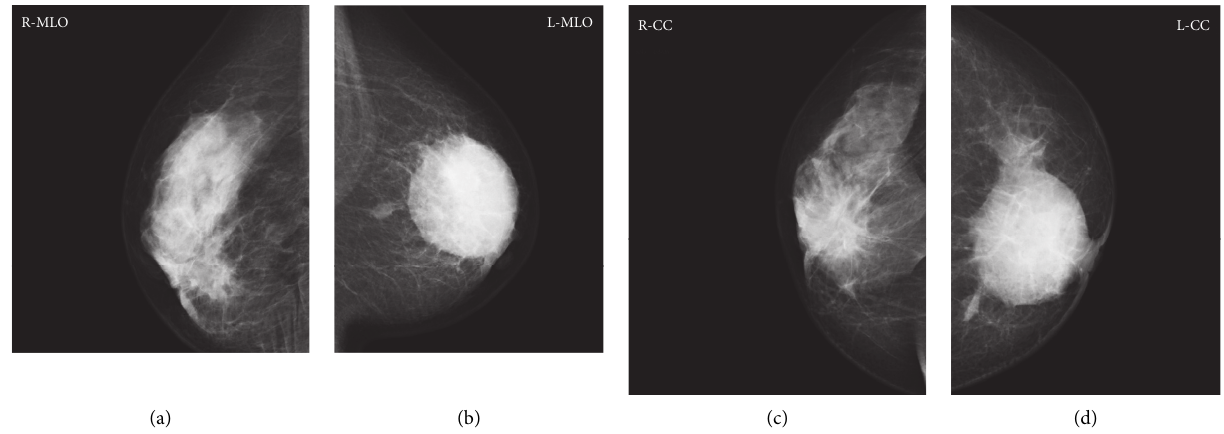
Figure 3: Mediolateral oblique (a, b) and craniocaudal (c, d) mammography demonstrates a round, microlobulated, and high-density mass lesion in the right breast (a, c) and circumscribed, round, and high-density mass lesion in the left breast (b,